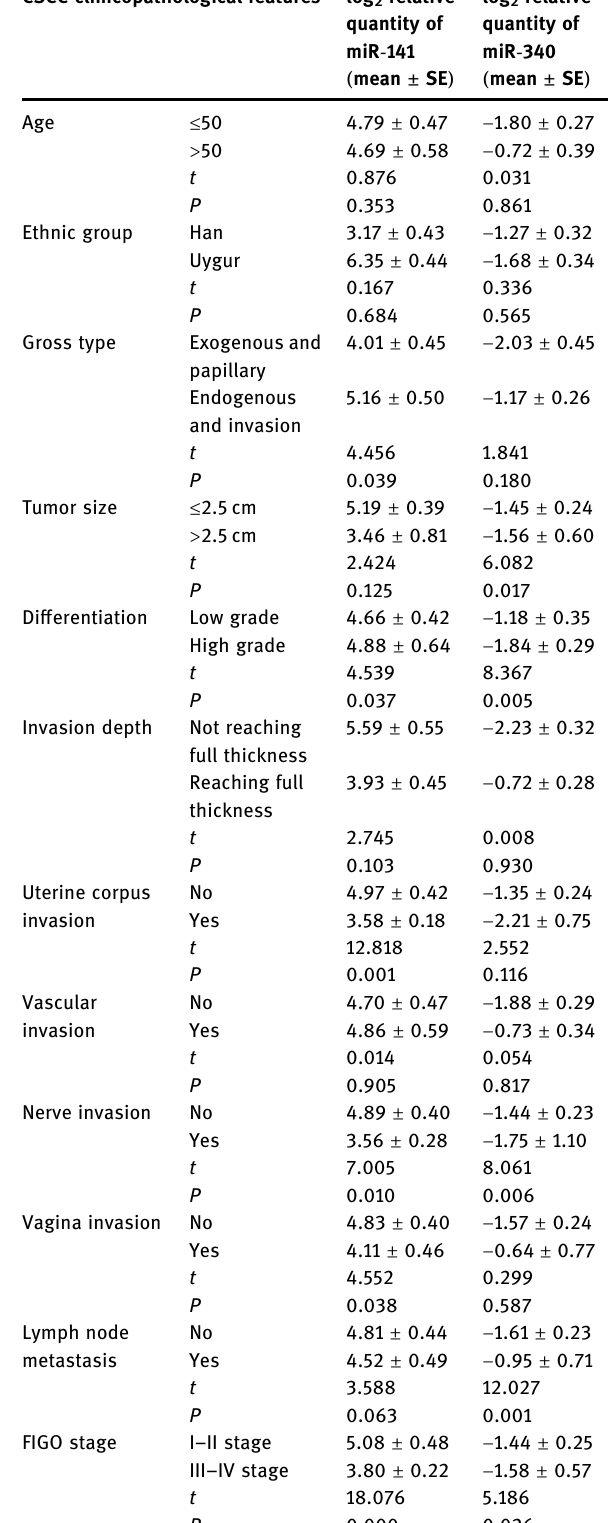
Table 2: miR - 141 in CSCC, HSIL, and normal squamous epithelium miR - 141